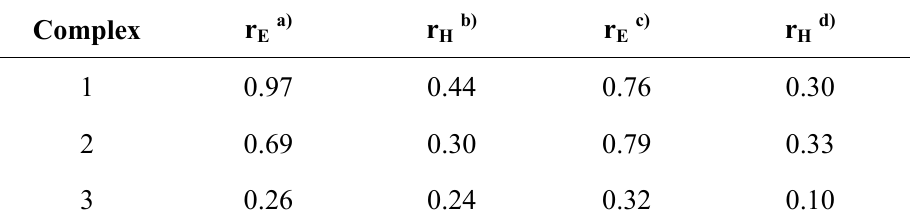
Table 3. Reactivity ratios for each copolymerization